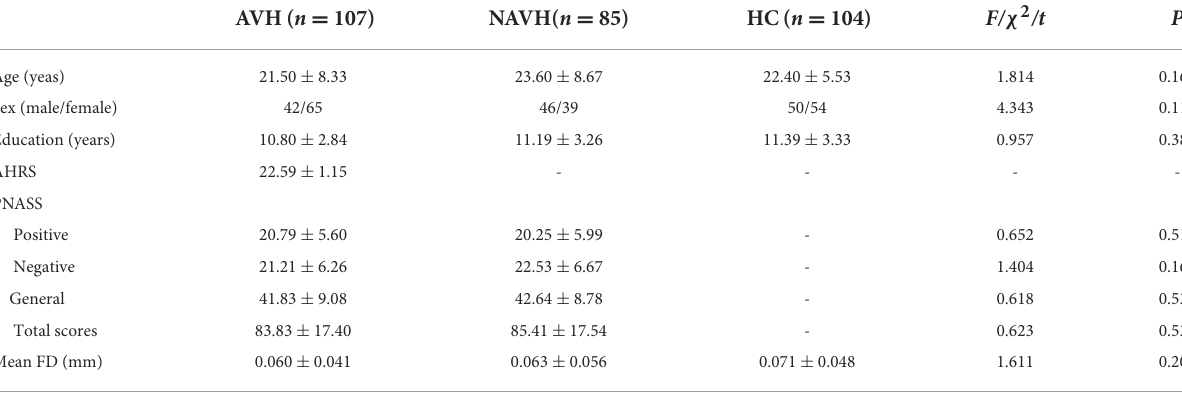
TABLE 1 Demographic and clinical data of AVH, NAVH, and HC groups [Mean